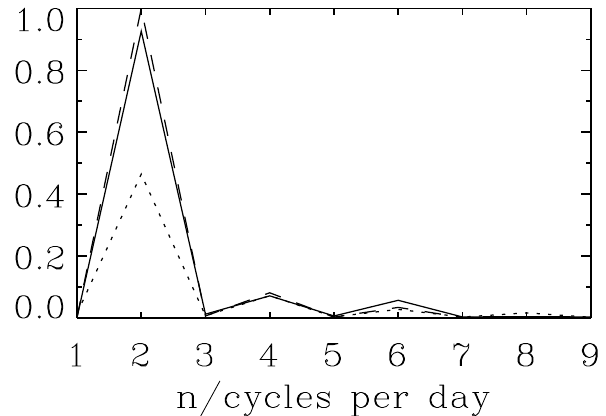
Fig. 10. Normalized frequency spectra of zonal wind disturbances at three selected points, which are respectively located at (180 ◦ , 45 ◦ S, 108km) (solid line), (180 ◦ , 45 ◦ N, 108km) (dashed line) and (180 ◦ , 0 ◦ , 108km) (dotted line).